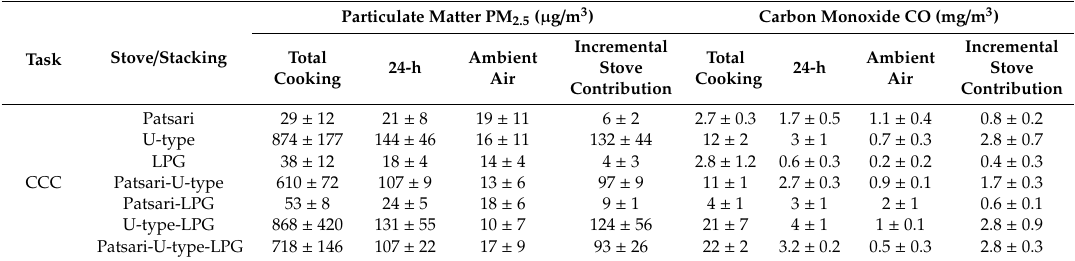
Table 2. Average cooking, 24-h, ambient air and stove contribution concentrations of PM 2.5 and CO by CCC.